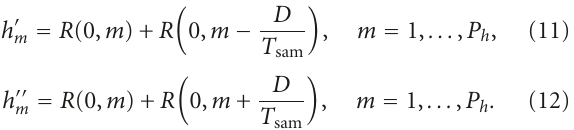
the bias vector b with a shift step of P samples, as shown in Figure 3. The matrix B δ (cid:13) of size ML s × ( MN f + 2 N f ) also has M +2 block columns, the nonzero parts of which are obtained from the bias matrix B in the same way as C δ (cid:13) . Since the bias is independent of the data symbols and the code, it is the same for each frame. Each column of the resulting matrix is the same and has a period of P B δ (cid:13) 1 ( MN f +2 N f ) × N